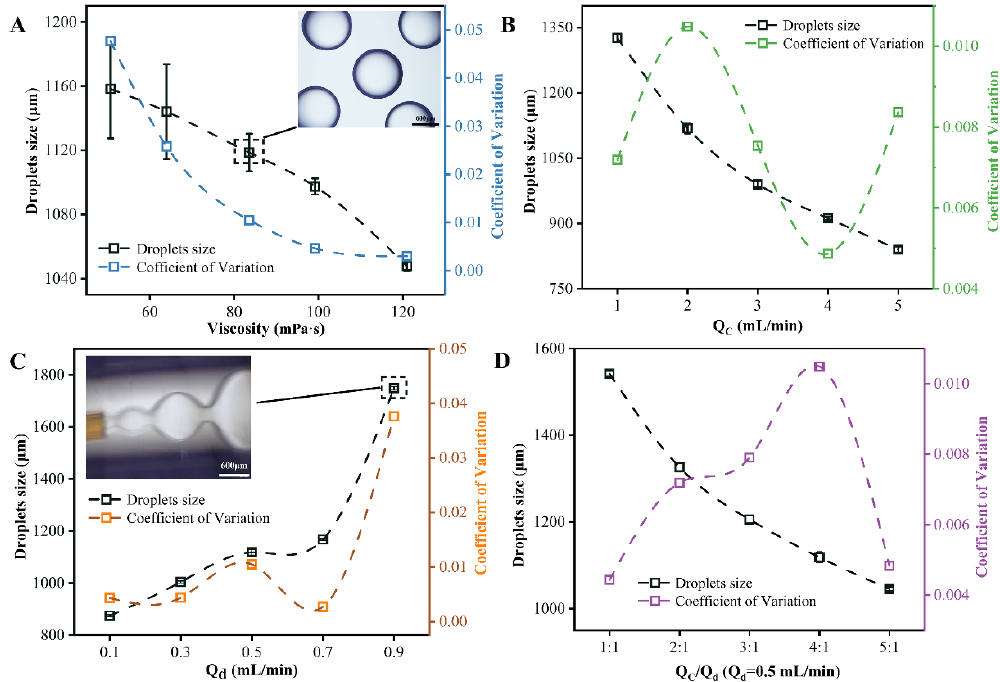
Figure 6. ( A )The viscosity of continuous phase. ( B ) The flow rate of continuous phase (Q c ). ( C ) The flow rate of dispersed phase (Q d ). ( D ) The flow ratio of continuous phase to dispersed phase.